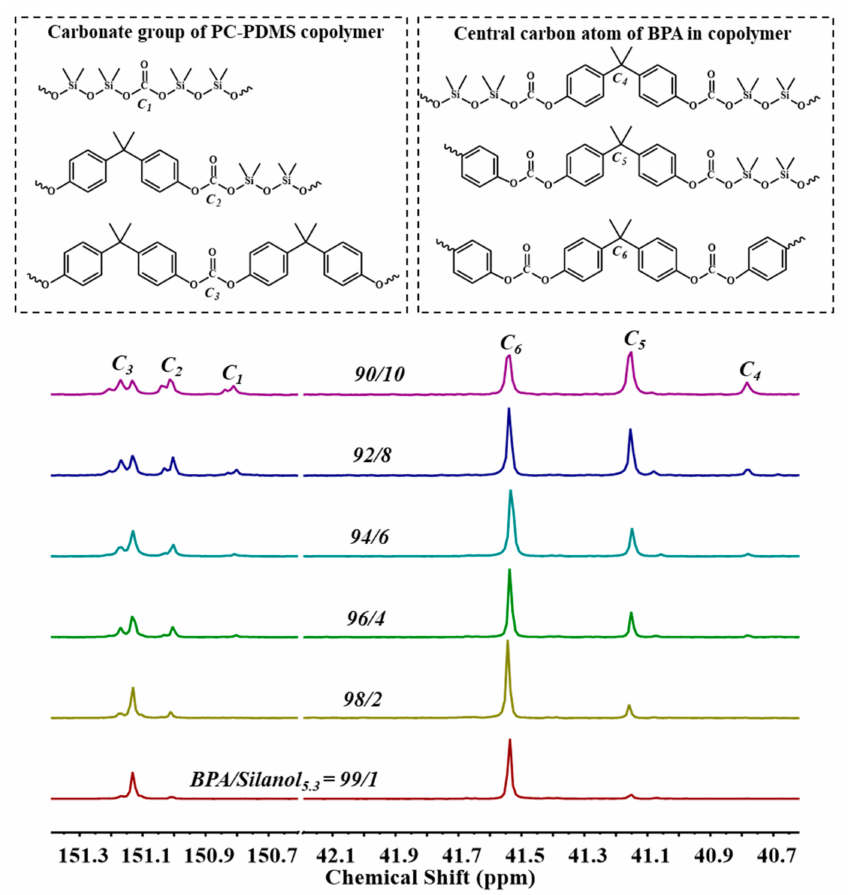
Figure 9. 13 C-NMR spectra of PC-PDMS copolymer with different feed ratios of BPA to Silanol 5.3